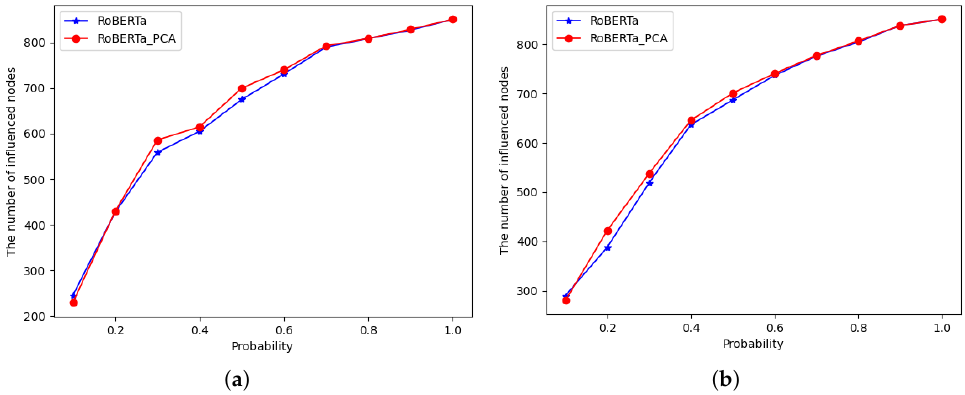
Figure 6. The spread of influence with different spreading probabilities for the proposed model with PCA and without PCA. ( a ) Biological computing data, ( b ) Membrane computing